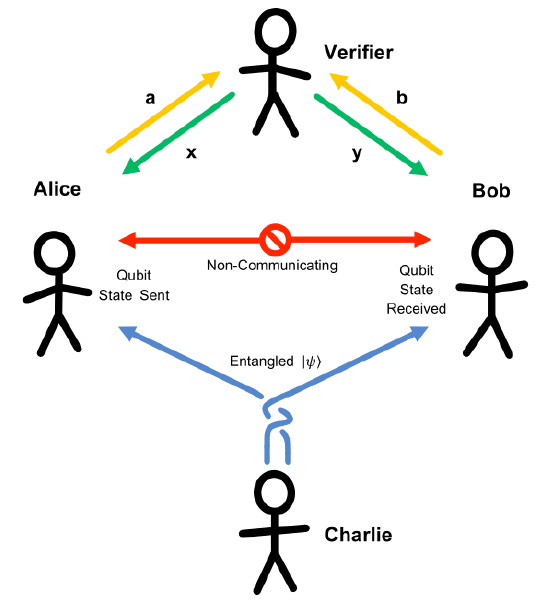
Figure 4 . An illustration of the quantum magic-square